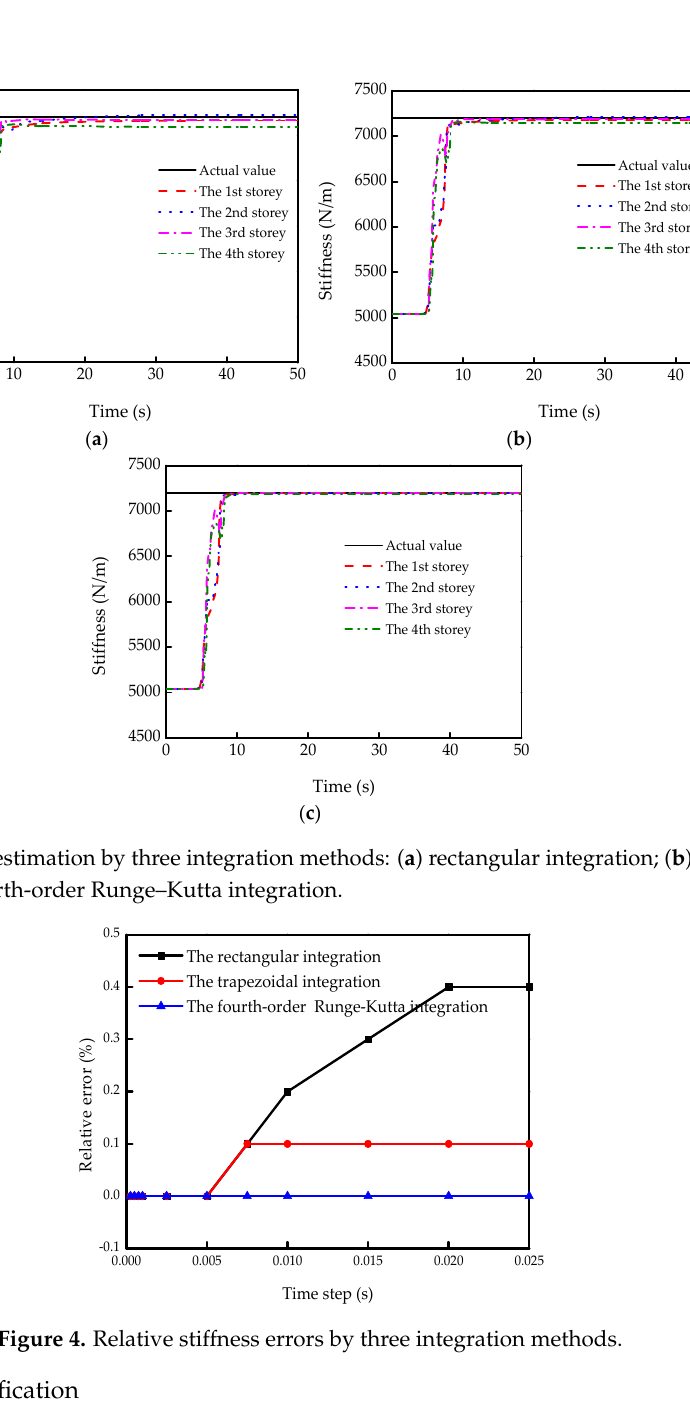
Figure 4. Relative stiffness errors by three integration methods.